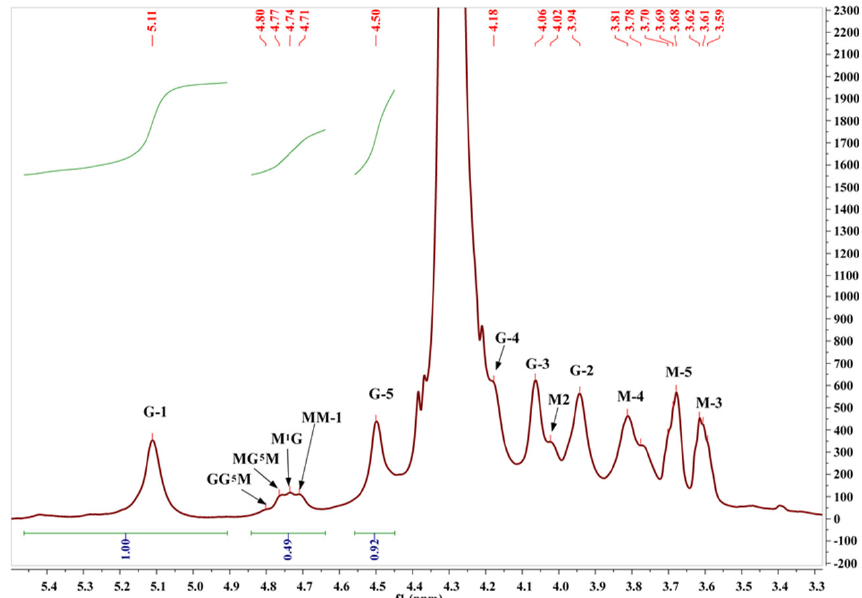
Figure 4. 1 H NMR spectrum of the extracted alginate. Table 3. Numerical values for the uronic acid composition, M/G ratio, and doublet frequencies of alginate extracted from C. sinuosa